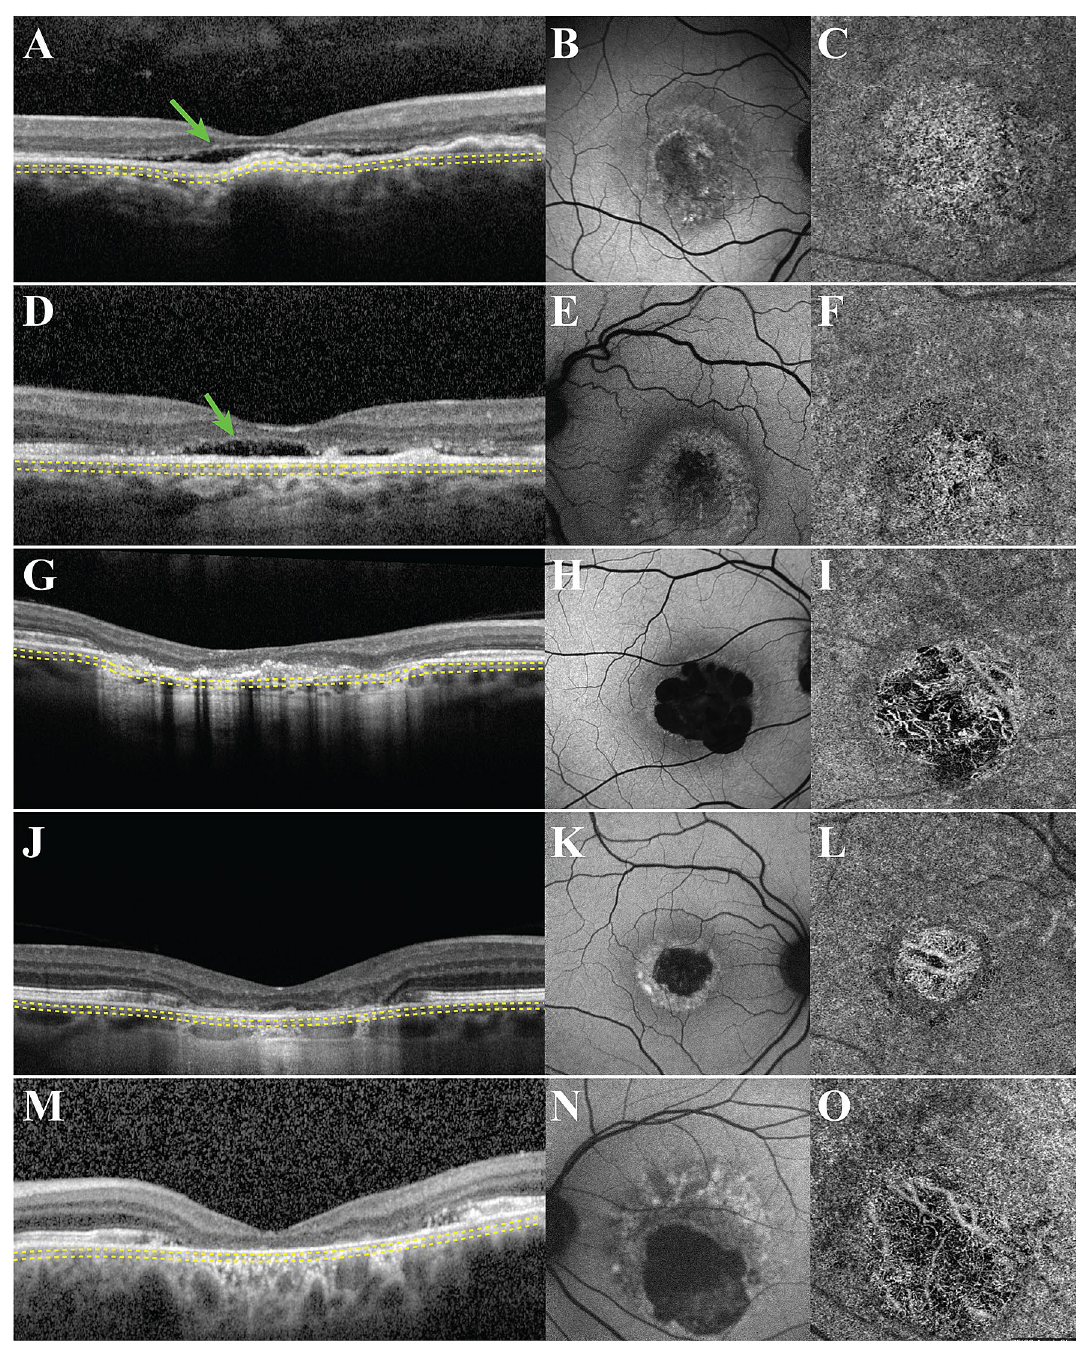
Figure 2. Multimodal imaging of eyes at the atrophic stage. Spectral-domain optical coherence tomography (SD-OCT) images revealed two different presentations of the atrophic stage. One presentation involves shallow, hyporeflective fluid, with loss of the interdigitation zone (IZ) band (green arrow) ( A , D ). The other presentation involves loss of outer retinal layers with subsequent collapse of the inner retinal layers ( G , J , M ). All of these lesions in SD-OCT images presented with increased signal transmission into the choroid. In short-wavelength fundus autofluorescence (SW-AF) images ( B , E , H , K , N ), these lesions corresponded to hypoautofluorescent (hypoAF) areas, with denser hypoAF observed in patients with collapse of the inner retinal layers on SD-OCT images ( H , K , N ). In OCTA images, the aforementioned lesions on SD-OCT and SW-AF imaging appeared as areas of bright choriocapillaris (CC), with varying degrees of atrophy. In the eyes with hyporeflective fluid, CC atrophy was patchy ( C , F ), whereas in the patients with collapse of the inner retinal layers, CC atrophy was more severe, with the underlying choroidal vessels visible ( I , L , O ). The yellow dashed lines on the SD-OCT images represent the approximate location of the CC